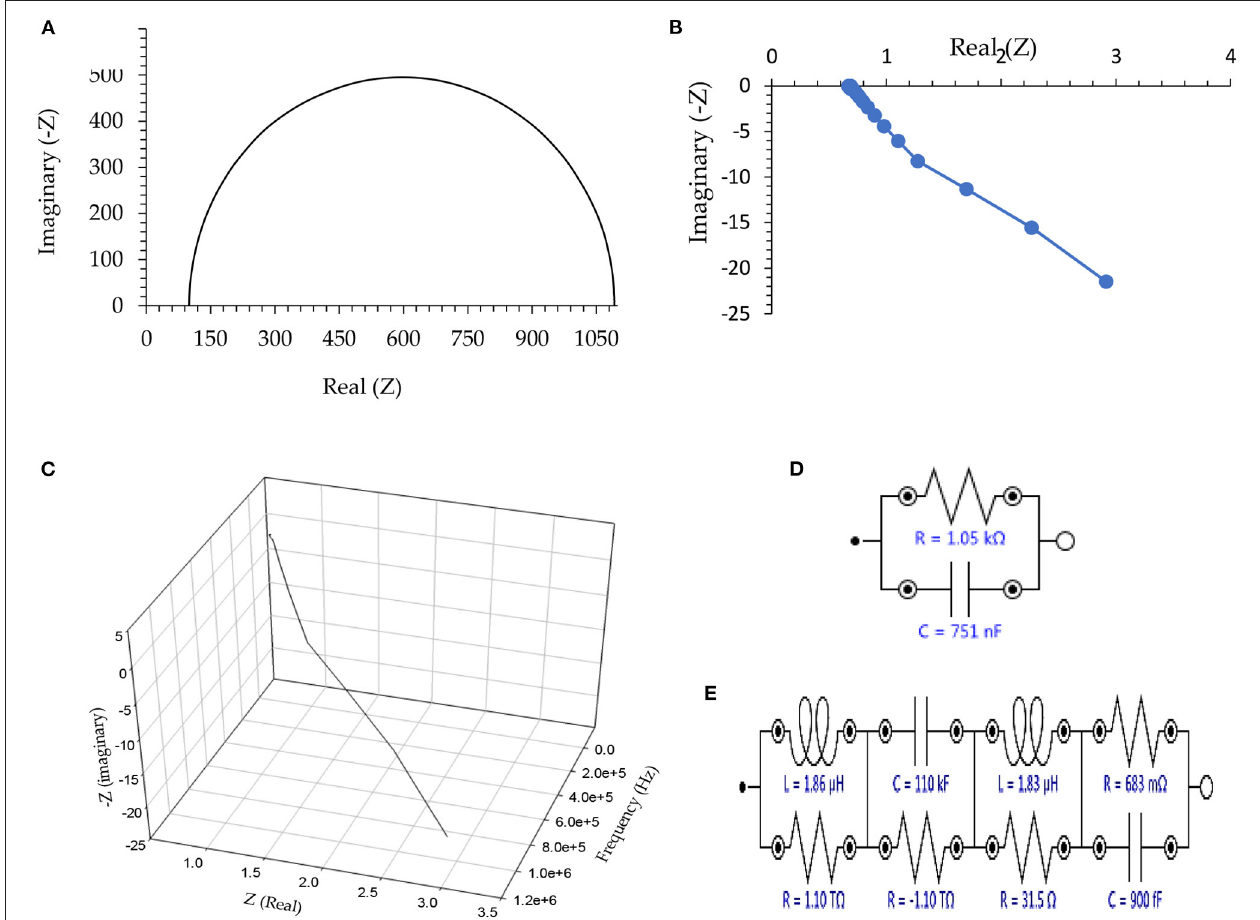
FIGURE 1 | (A) Nyquist plot in the absence of any connection to the helminth egg, (B) Two-dimensional Nyquist plot for Taenia multiceps, (C) Three-dimensional Nyquist plot of Taenia multiceps (as a sample), (D) Equivalent circuit as an example for the absence of the helminth egg, and (E) Equivalent circuit as an example for Taenia multiceps. Conditions: All conditions and procedures are expressed in detail as mentioned- above during implanting two microelectrodes with 0.0124 0.0008mm inter-electrode distance, error bar: : Standard deviation ( n ± =